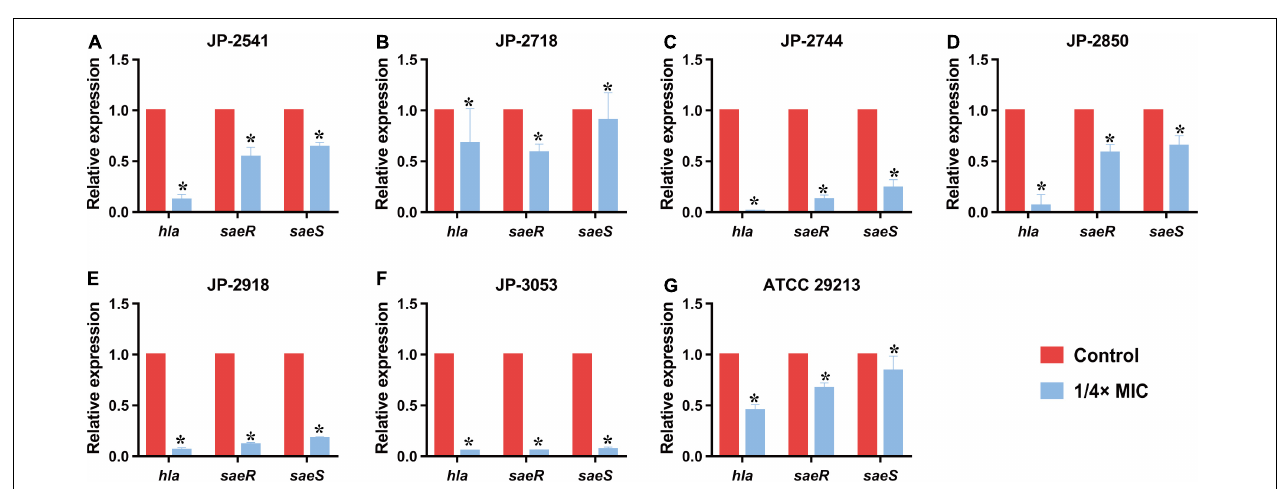
FIGURE 5 | Different concentrations of CDB used to disrupt the bacterial cell membrane integrity. * P < 0.05; N.S., P > 0.05.